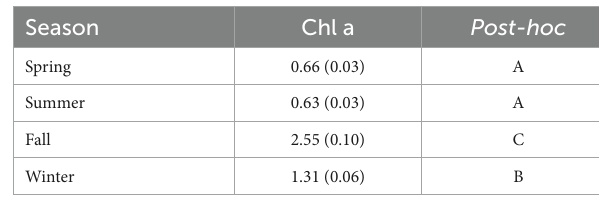
TABLE 2 Mean chlorophyll concentrations ( μ g L − 1 ) at different seasons, site topographies, and depths with the standard error in paratheses.